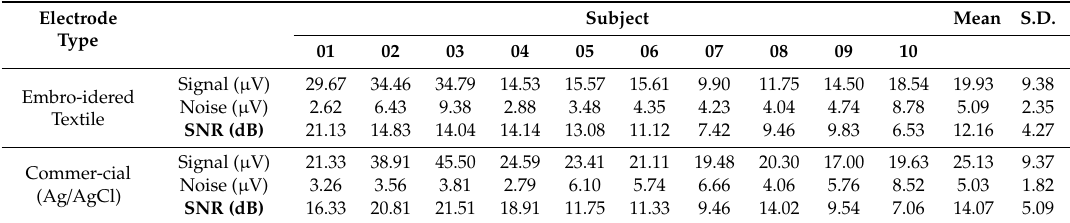
Table 1. Total SNR of the ten subjects.